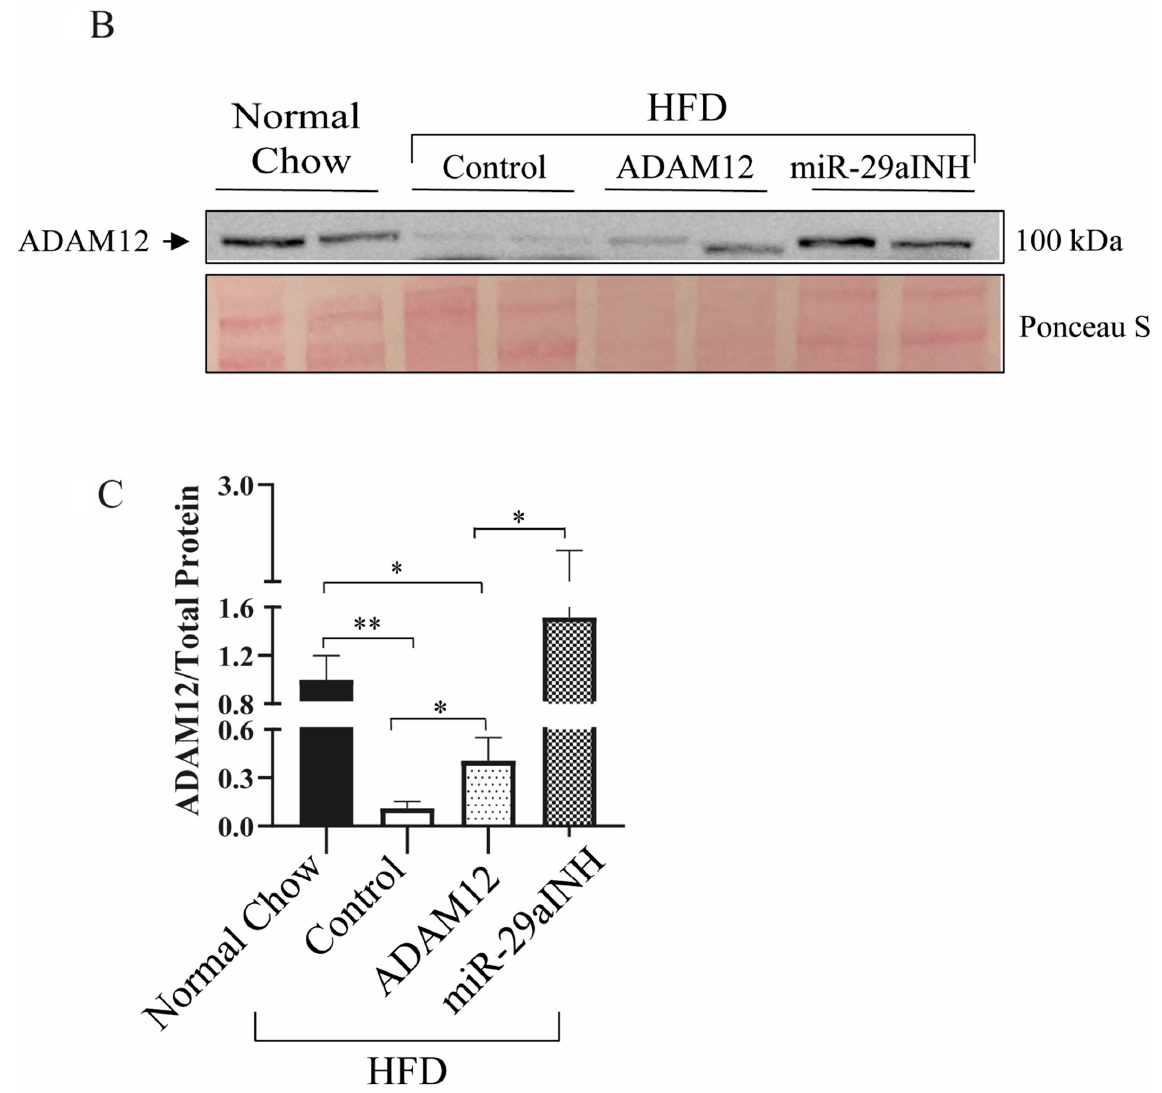
Figure 2. ADAM12 gene transfer and miR-29a inhibition in ischemic GA muscle of HFD mice increased ADAM12 mRNA and protein expression. ( A ): Increased ADAM12 mRNA expression in ischemic GA muscle of HFD mice following ADAM12 gene transfer and miR-29a inhibitor treatment (** p < 0.005, Normal Chow: n = 5, HFD Control: n = 5, HFD + ADAM12: n = 4 and HFD + miR29aINH: n = 4). ( B ): Increased ADAM12 protein expression in ischemic hindlimbs of HFD mice following ADAM12 gene transfer and miR-29a inhibitor. ( C ): Quantification of ADAM12 expression relative to total protein by ponceaus staining is shown (* p < 0.05, ** p < 0.005 and Normal Chow: n = 5, HFD Control: n = 5, HFD + ADAM12: n = 5 and HFD + miR29aINH: n =